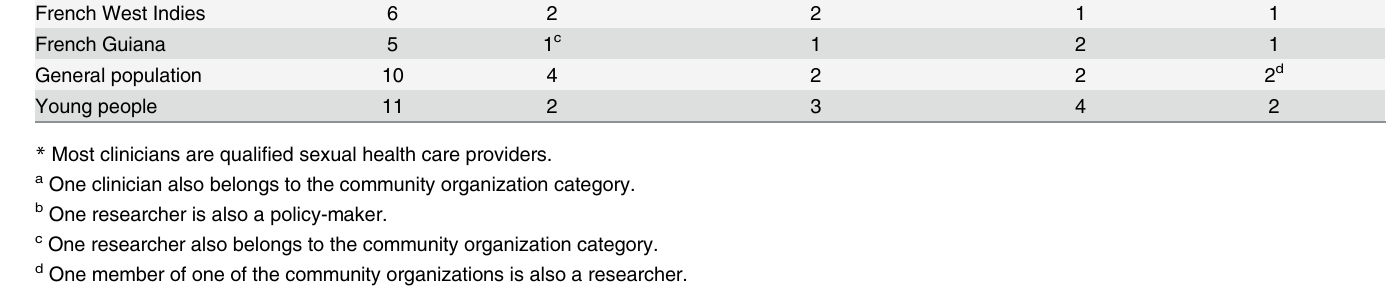
57 respectively for the same number of experts for Substance Users and the General Popula- tion, or to 48 for the nine experts in the Transgender group. This was a first indication of the considerable interest of the self-test for MSM experts compared to the experts for other popula- tion groups. With regard to high-scoring recommendations (mean score (cid:1) 7), the General Pop- ulation expert group stood out with only 35% of recommendations with mean scores (cid:1) 7, compared to the migrants from sub-Saharan Africa or Transgender groups with 79% and 88%, respectively.